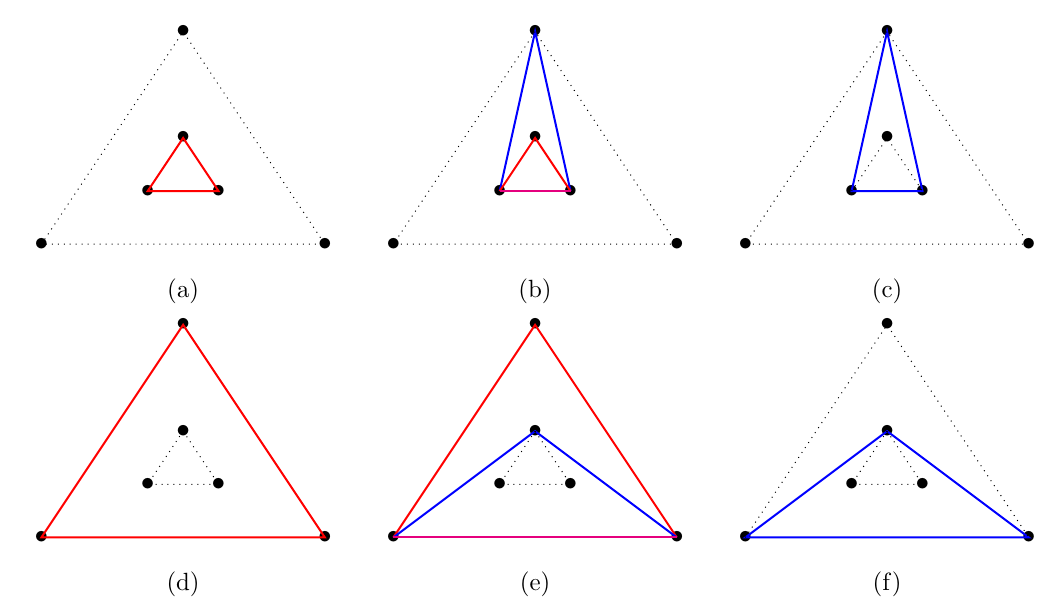
Figure 6. C [ (cid:22) R ] and C [ (cid:22) L ] brane plus intra and inter-brane Higgs. Here, we display example solutions involving only one triangular con(cid:12)guration. There exists a continuously parametrized solution interpolating between (a) and (c), while all intermediate states can be thought of as in (b). In addition, there exists another continuously parametrized solution interpolating between (d) and (f), while all intermediate states look like (e). Legs depicted with the same color have the same amplitude. In particular, the intermediate states have (cid:12)ve legs with three di(cid:11)erent, but related amplitudes.